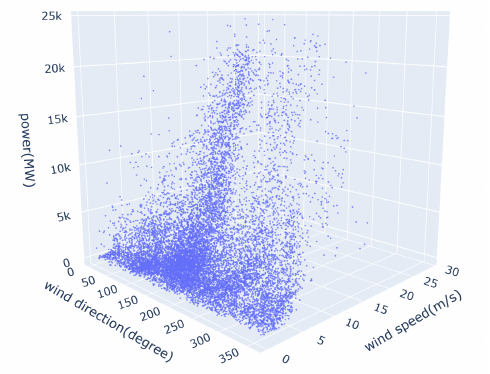
Figure 6. Three-dimensional graph for the relations among wind direction, wind speed, and power